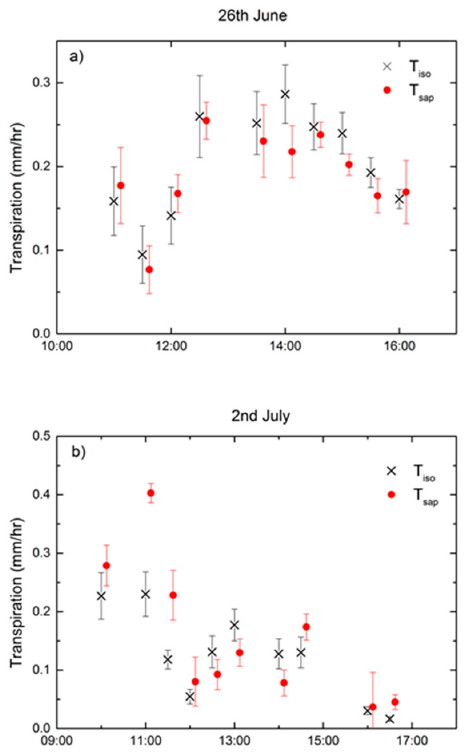
Figure 8. Comparison of isotope and sap flow estimates of transpiration (T) for ( a ) 26 June and ( b ) 2 July. Error bars depict standard error.